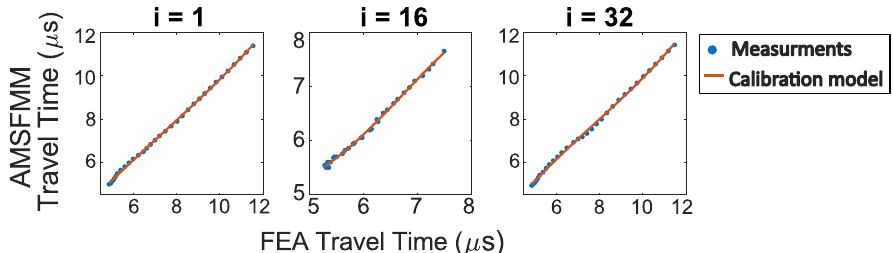
Figure 5. The calculated travel times at all receiving elements for the anisotropic multi-stencil fast marching method (AMSFMM) plotted against the travel times taken from the finite element analysis (FEA) models, plotted for three transmitting elements s i , where i is the transmitter index. The data are fit with a third degree polynomial G (red curves), which is for calibrating the FEA generated data so it can be used with the DNN trained on AMSFMM